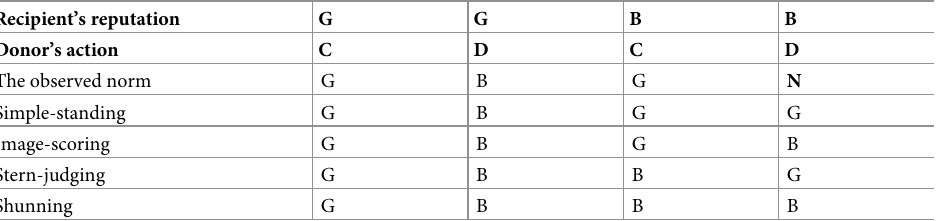
Table 2. How social norms make assessments in indirect reciprocity: “G” and “B” describe a good and bad reputa- tion, respectively. “C” and “D” denote cooperation and defection, respectively. “N” means the reputation of a donor remains neutral